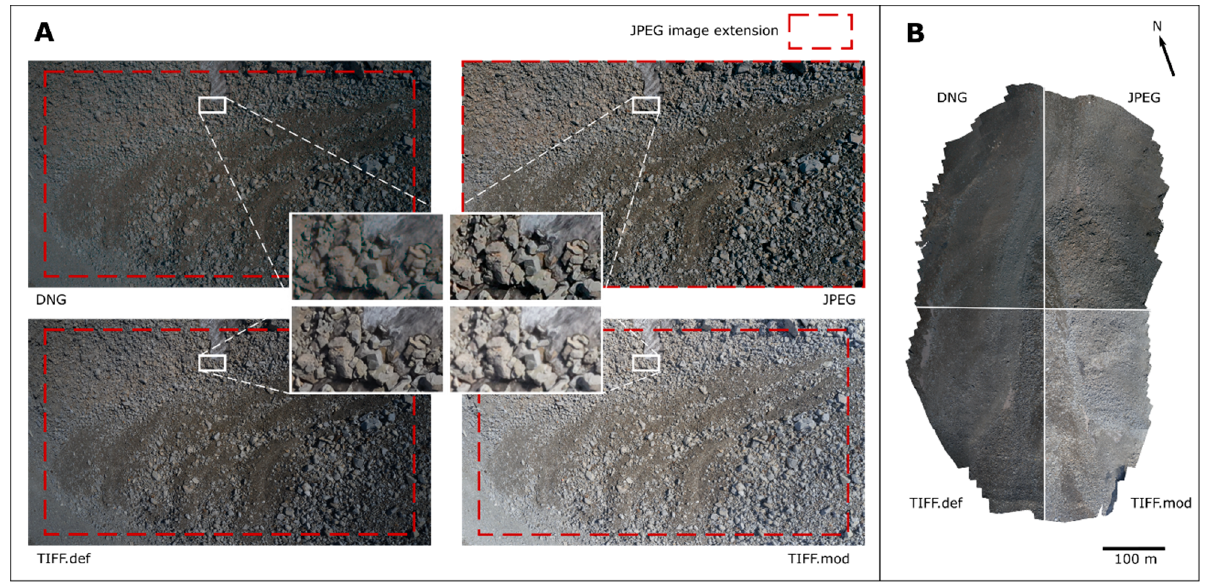
Figure 4. Effect of image properties on the appearance of photographs and 3D surveys. ( A ) Detail of the images used in the photogrammetric reconstructions. DNG: Raw imagery from DJI Mavic 2 Pro UAV (Hasselblad L1D-20c camera). JPEG: Imagery processed by the UAV camera. TIFF.def: Imagery with build-in lens profile removed and automatic parameters modification from the image editing software. TIFF.mod: Imagery with build-in lens profile removed and user-defined parameters. ( B ) Top view of the dense point clouds from the photogrammetric reconstruction for each image set.